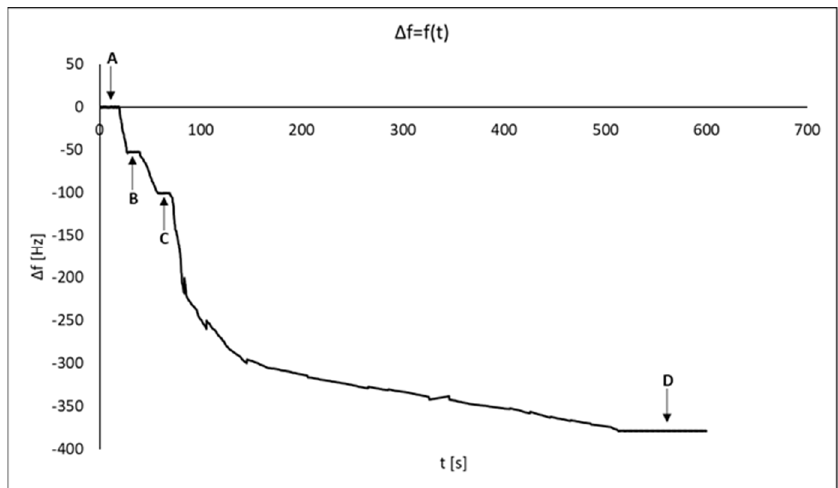
Figure 7. Graph of the dependence of frequency changes on time and successive layers of the bio- sensor. ( A ) pure gold; ( B ) cysteamine; ( C ) ligand; ( D ) VEGF-R2.